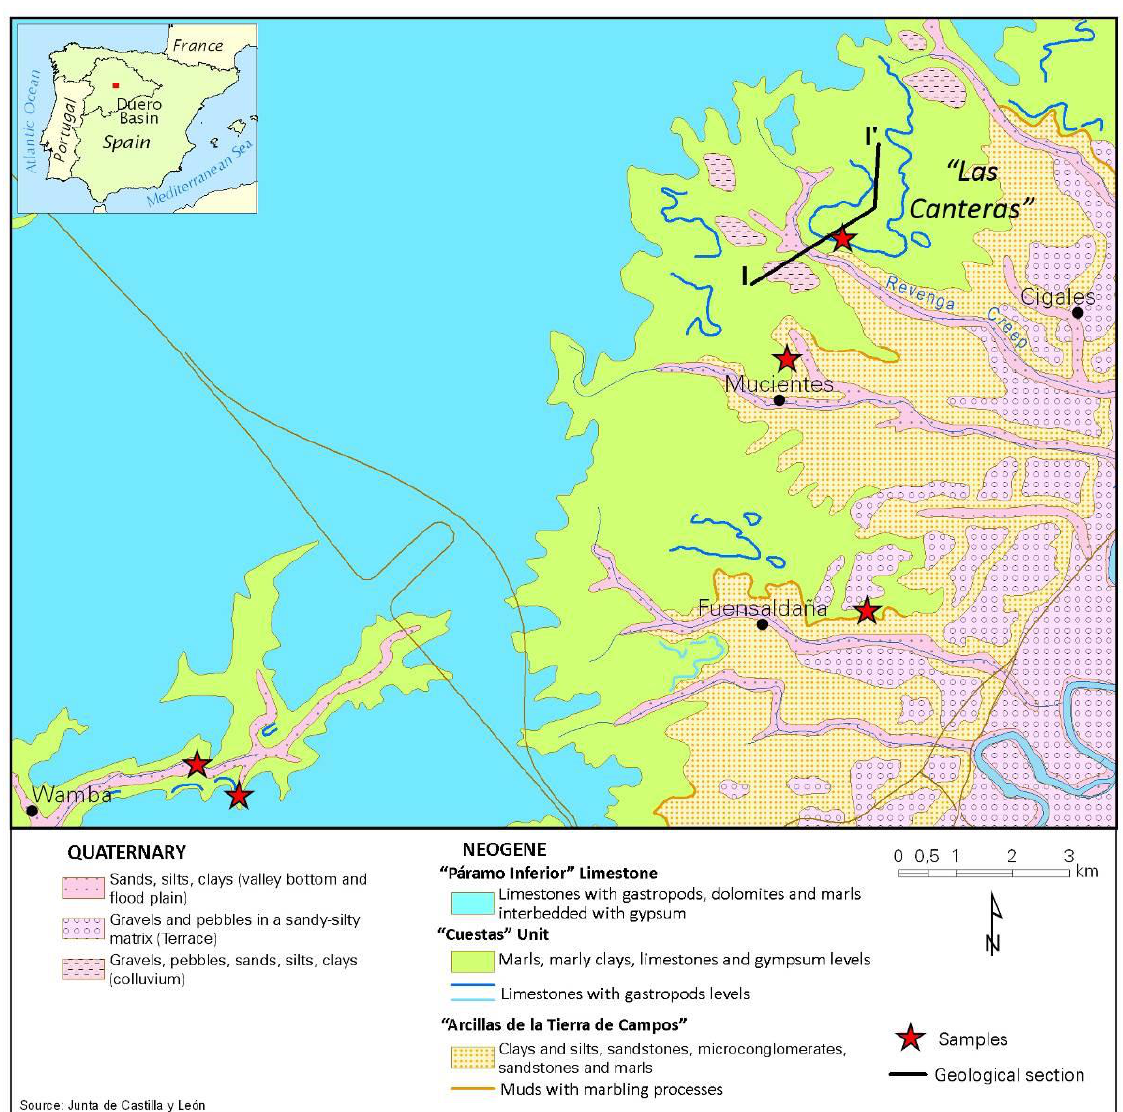
Figure 4. Detailed geological map of the Mucientes area (Source: Cartographic database of Junta de Castilla y León; Geology: synthesis from Portero 1982 and Piles et al. 2007). Stars mark the location of the samples found, especially in Las